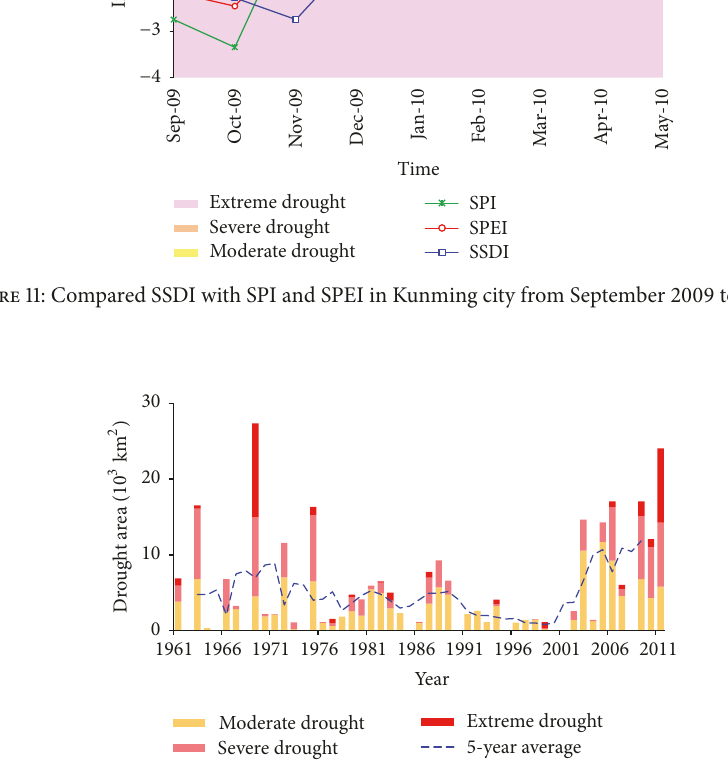
DD, and DS indicated that the grids for greater DS with